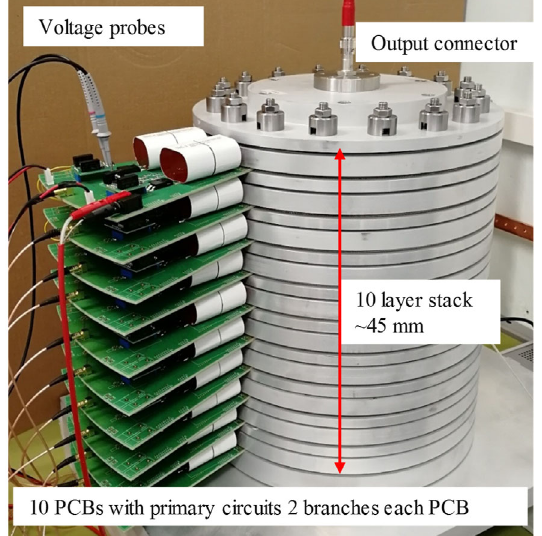
FIG. 7. Ten-layer small-scale prototype IA for the FCC study.